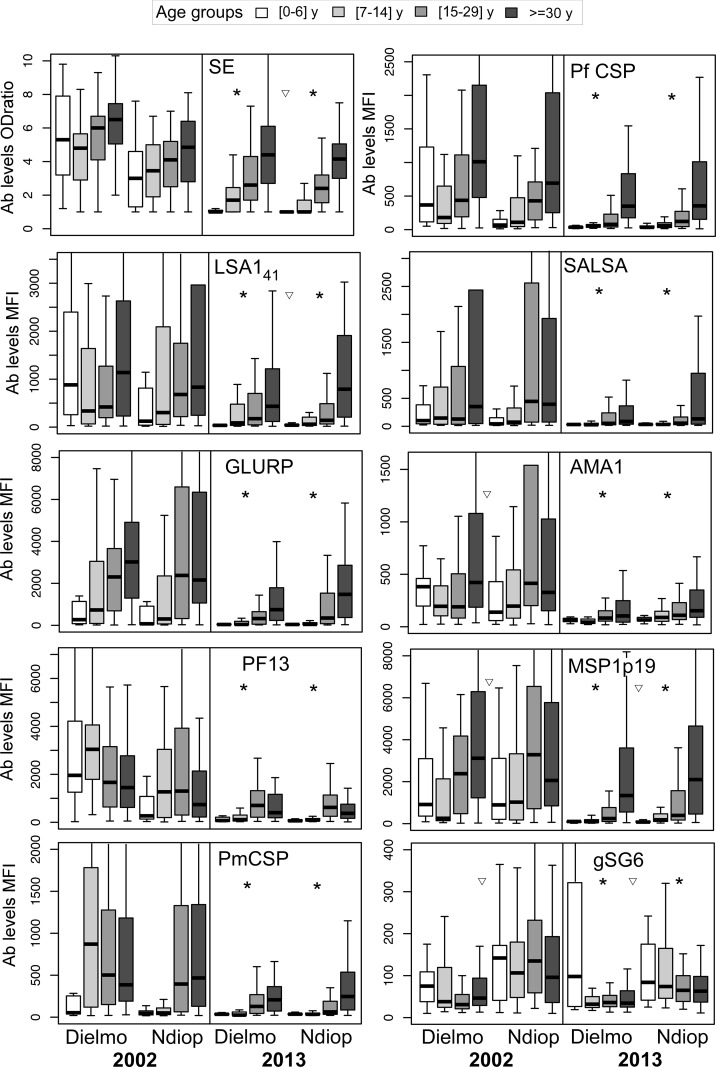
Distribution of antibody levels against ten antigens in Dielmo and Ndiop during the cross sectional surveys conducted in July 2002 and July 2013, by age group.Antibody levels against the ten antigens observed in four age groups <7y (white), 7–14 y (light grey), 15–29 y (dark grey) and ≥30 y (black) in Dielmo and Ndiop are shown as box-and-whisker plots. The box shows the first to the third quartile range, the band inside represents the median, the ends of the whiskers represent the 95% percentiles. Asterisks above the 2013 distributions indicate a significant intra-village decrease between 2002 and 2013 (P<10−2). Triangles indicate a significant inter-village difference of levels, ie against SE, AMA1, MSP1p19, gSG6 in 2002 and SE, LSA141, MSP1p19, gSG6 in 2013. The number of individuals within each age group for each survey and the P values of the various comparisons are presented in the S2 Table.